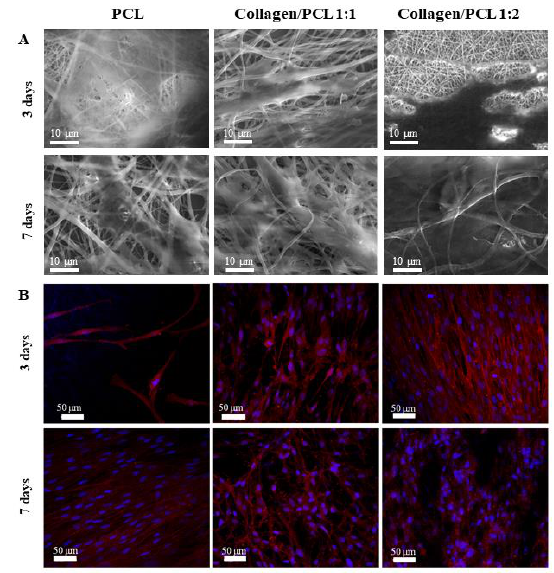
Figure 12. Fibroblasts growth and adhesion on nanofibers after 3 and 7 days culture. ( A ) SEM photomicrographs ( B ) confocal laser scanning microscopy (CLSM) images (nuclei blue marked with Hoechst, cytoskeleton red marked with Phalloidin-TRITC).